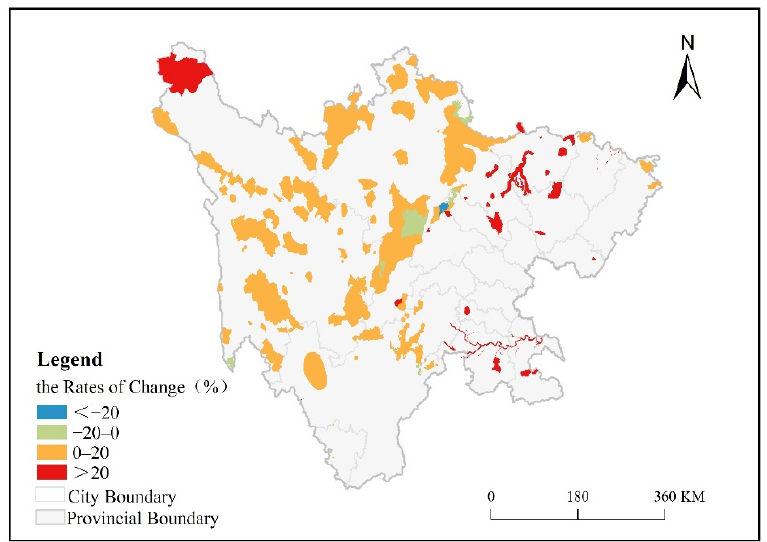
Figure 4. Rates of change in annual average NPP in Sichuan protected areas over 20 years.